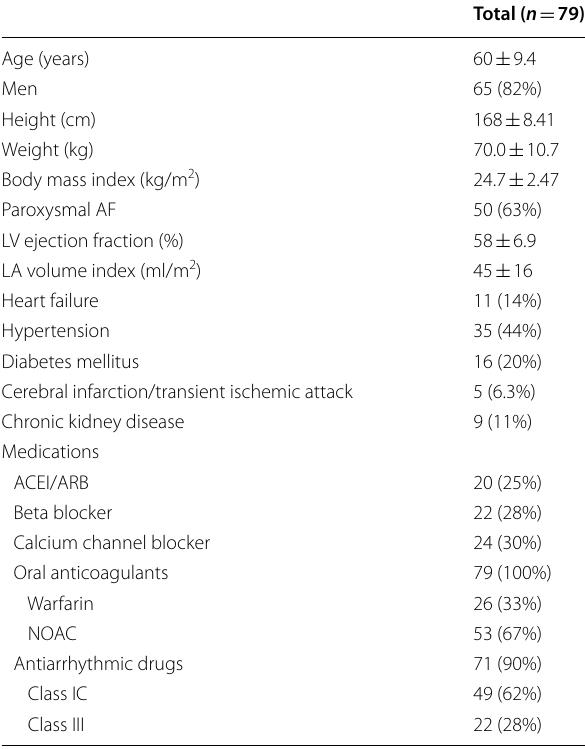
Table 1 Demographics of enrolled